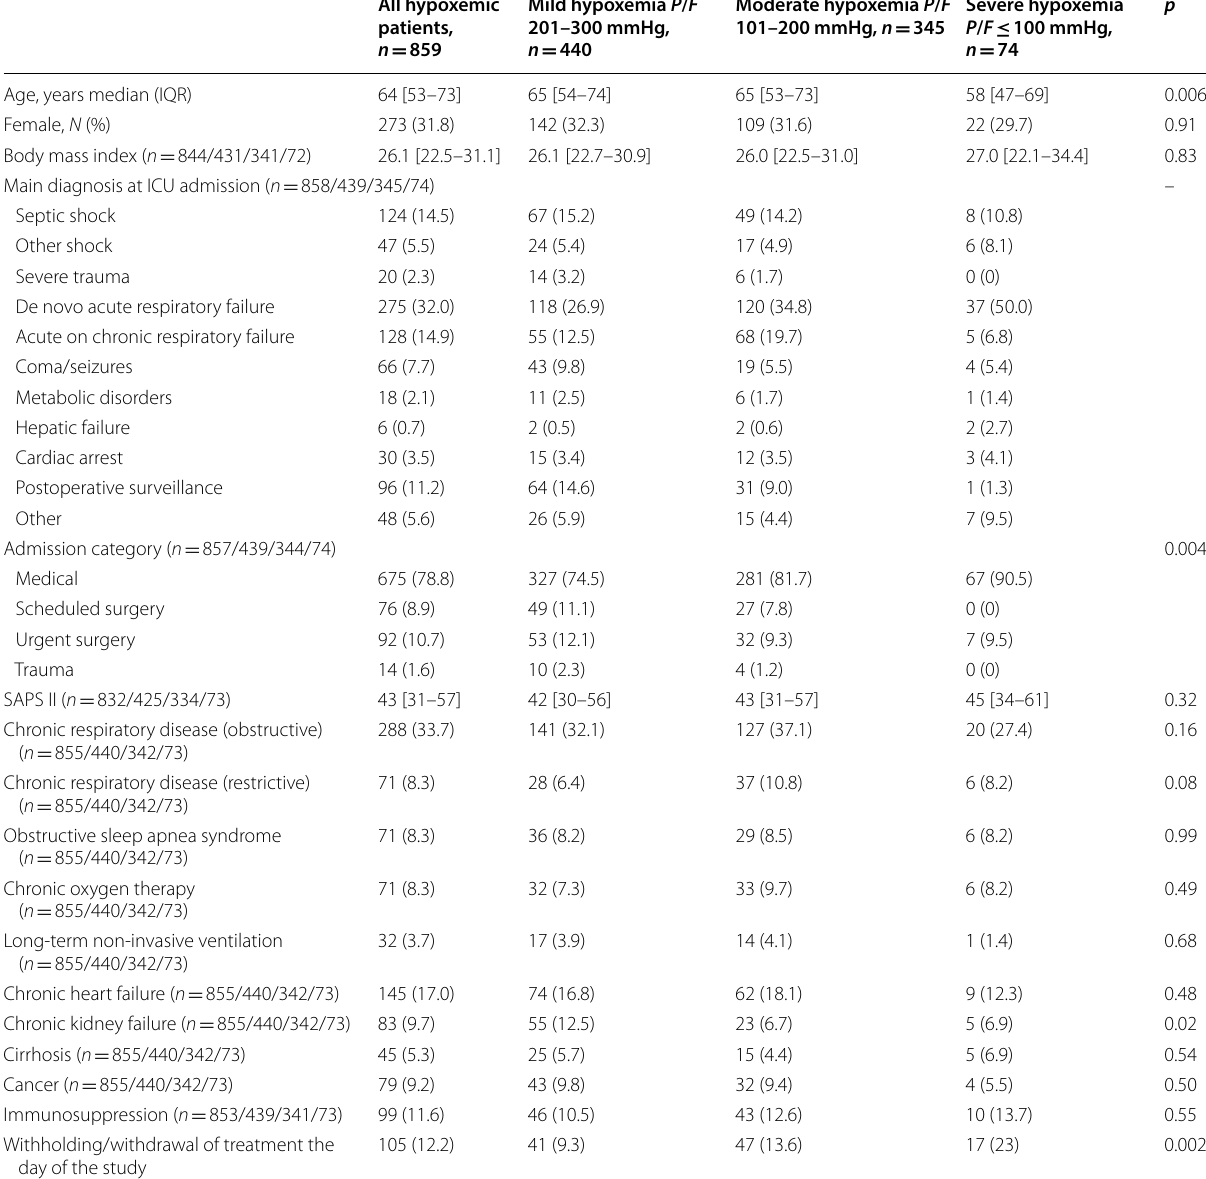
Table 1 Characteristics of hypoxemic patients according to severity of hypoxemia